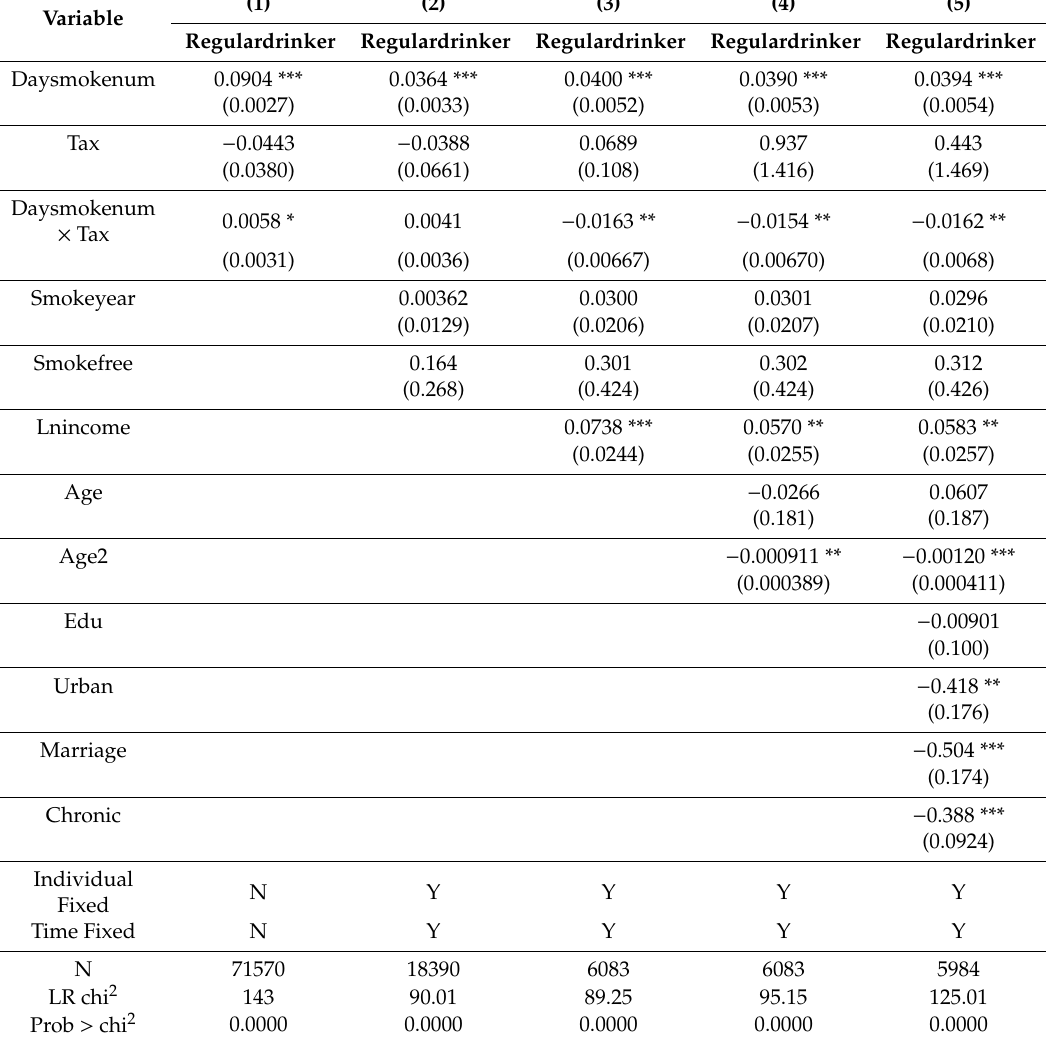
Table 4. Regular drinking behavior responses to the cigarette tax and